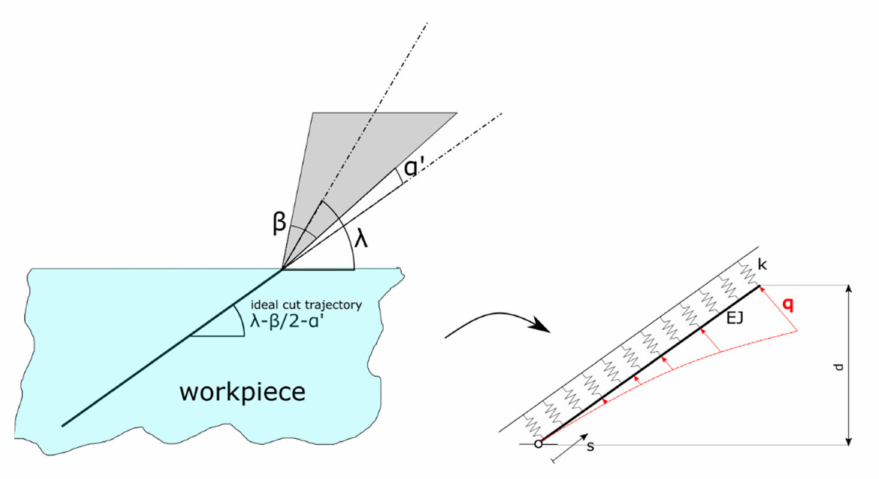
Figure 12. The proposed beam model for the prediction of the deformation of top surface of the groove generated during the incipient chip